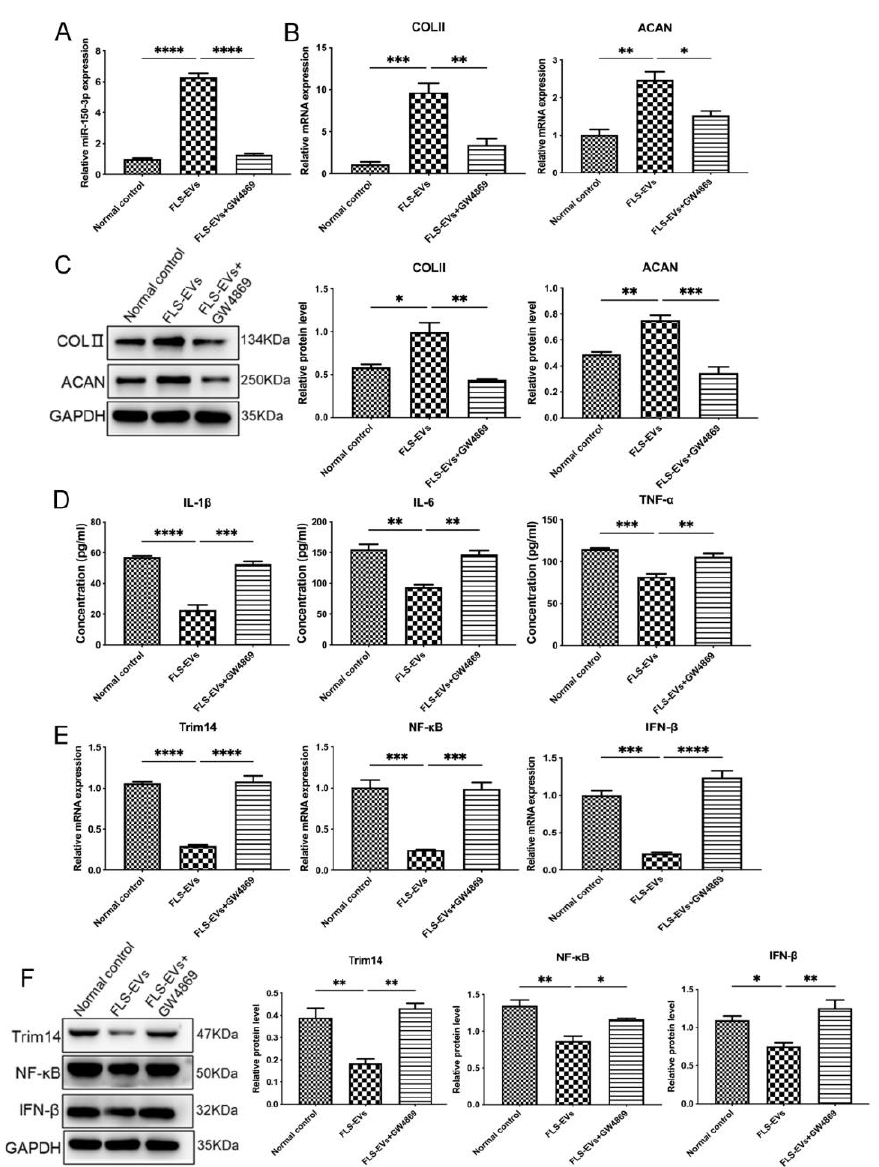
Figure 8. The mechanism underlying the effect of EVs-150 on chondrocyte repair. ( A ) qPCR analysis of the miR-150-3p expression in chondrocytes treated with H-FLS–EVs or GW4869. ( B ) qPCR analysis of the COLII and ACAN mRNA levels in chondrocytes upon H-FLS–EV treatment. ( C ) The COLII and ACAN protein levels in chondrocytes using WB upon H-FLS–EV treatment. ( D ) ELISA-based quantitation of the pro-inflammatory cytokines IL-1 β , IL-6, and TNF- α in the chondrocyte culture medium. ( E ) qPCR analysis of Trim14, NF- κ B, and IFN- β mRNA levels. ( F ) WB analysis of Trim14, NF- κ B, and IFN- β protein levels. The data are expressed as mean ± SEM from three independent experiments. **** p < 0.00001, *** p < 0.0001, ** p < 0.01, * p < 0.05. 3.6. miR-150-3p Regulates the Innate Immune Signal Transduction to Maintain Joint Homeostasis To elucidate the mechanism underlying the regulation of Trim14 expression by miR- 150-3p and its relationship with the NF- κ B signaling pathway, we analyzed the binding site between miR-150-3p and the 3 (cid:48) end of Trim14 by using TargetScan. A plausible binding site was identified in the promoter region of Trim14. As shown in Figure 9A, the promoter fragments were significantly inhibited by miR-150-3p expression, indicating that Trim14 is a direct target of